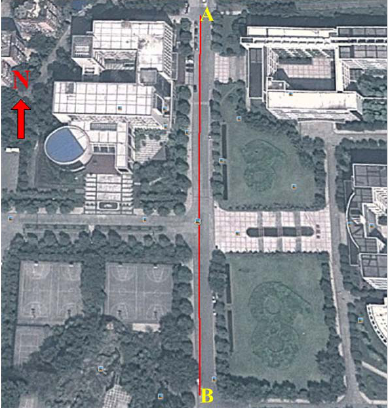
Figure 14. Open sky environment.